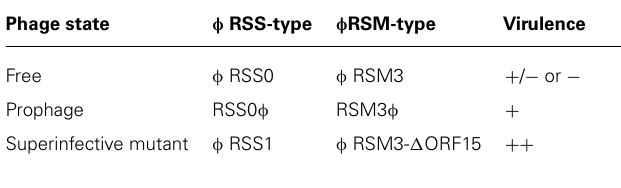
Table 1 |Three states of filametous phages and their effects on host